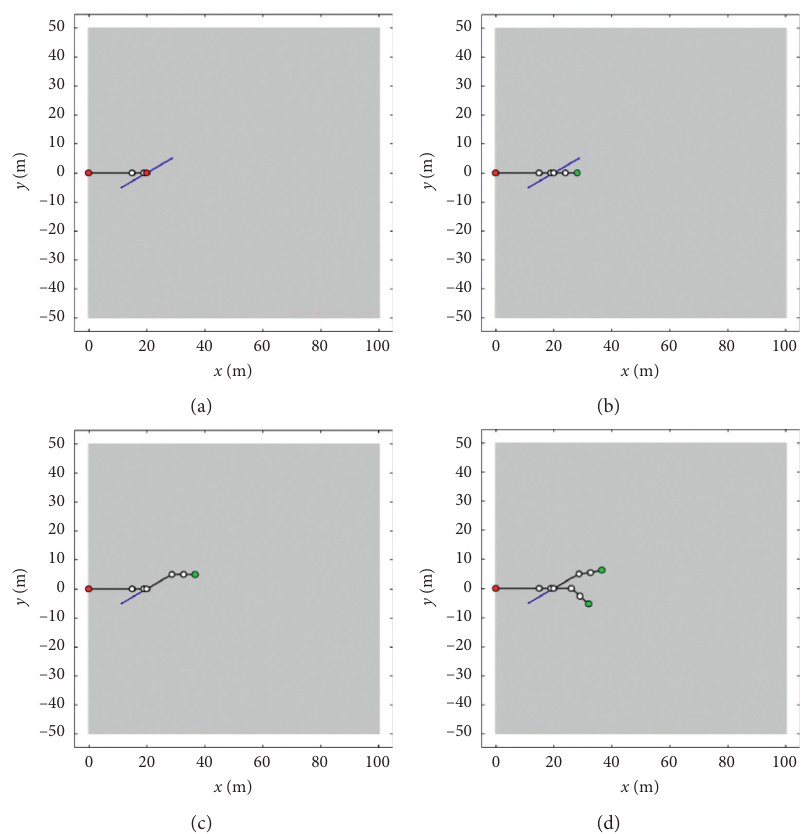
Figure 10: Intersection results based on the W&T’s criterion under different fluid pressure conditions. (a) Final fracture, 2.5MPa. (b) Final fracture, 2.8MPa. (c) Final fracture, 3.5 MPa. (d) Final fracture,